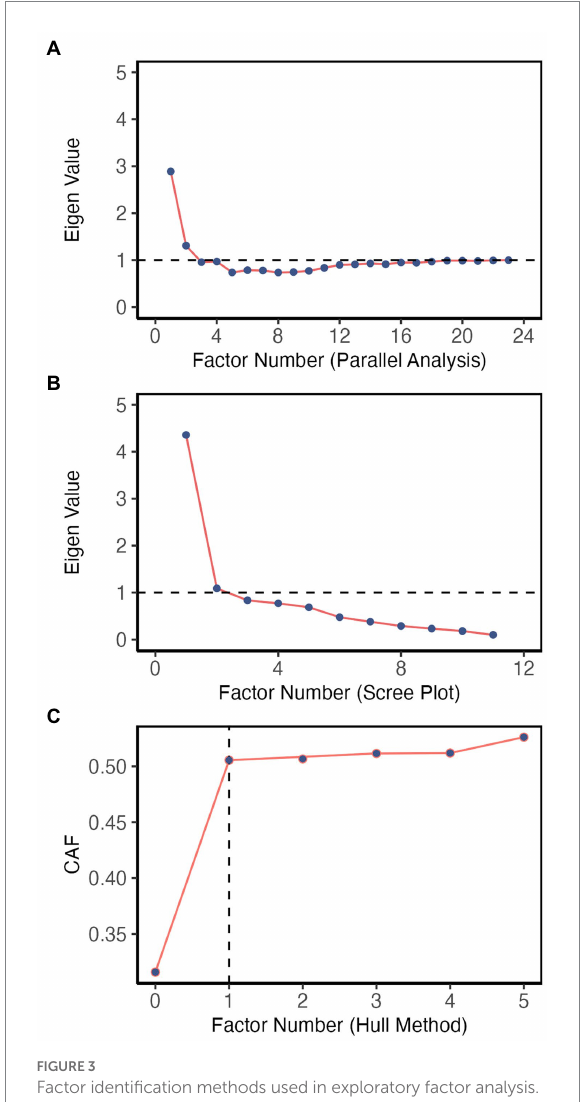
FIGURE 3 Factor identification methods used in exploratory factor analysis. (A) Parallel analysis indicates a two-factor solution. (B) Scree plot indicates a two-factor solution. (C) Hull method indicates the one-factor solution.